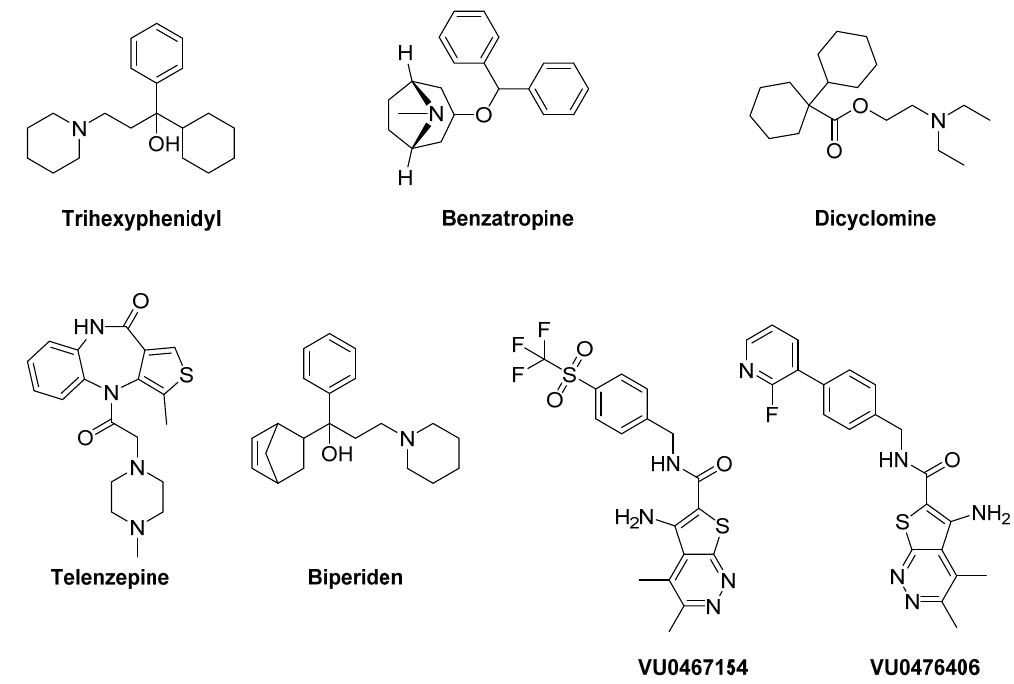
Figure 13. Muscarinic receptor ligands.